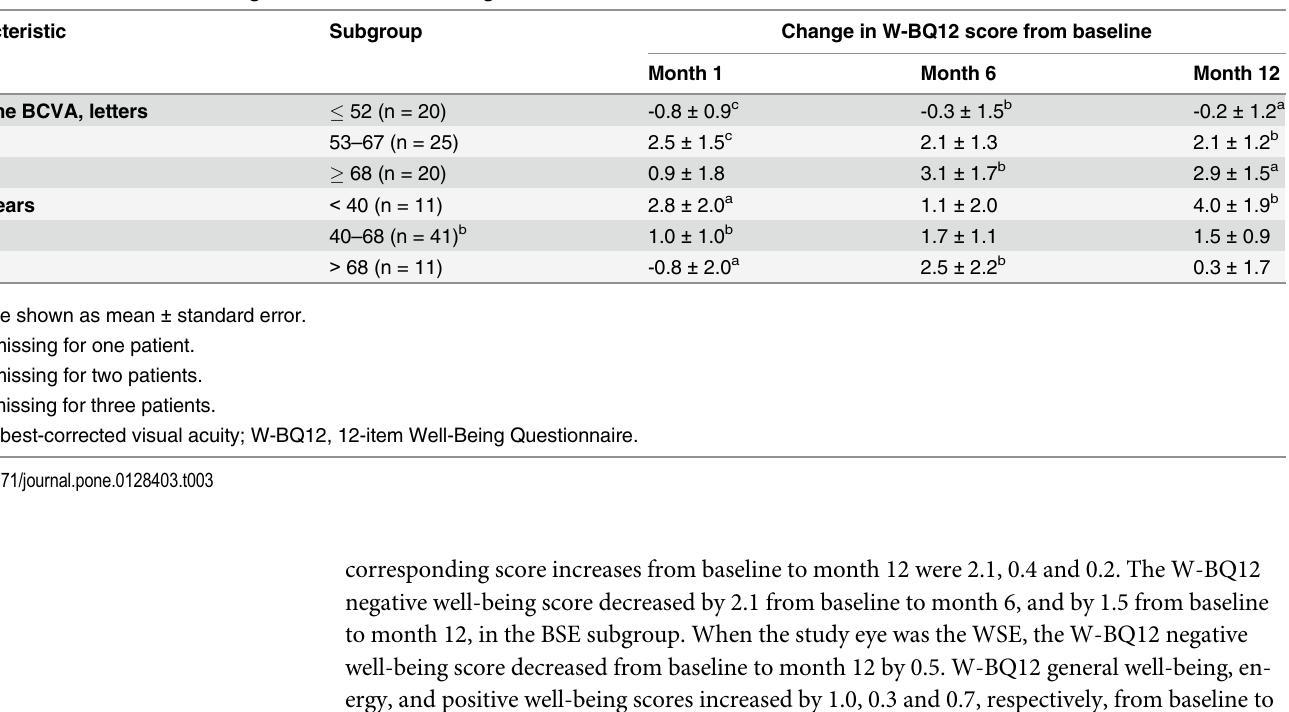
scores, although the greatest increase from baseline to month 12 was reported by patients re- ceiving two or three injections (mean change, +3.49) (Fig 4C). score were weak at all time points assessed (month 12, r = 0.02 for both correlations). Correla- tions between MacTSQ total score and W-BQ12 general well-being score were also weak (month 12, r = 0.08) (S2 Table, available online). Strong correlations were found between total score and subscale scores for each PROM, but subscale scores correlated only weakly across in- struments (S3 Table, available online).